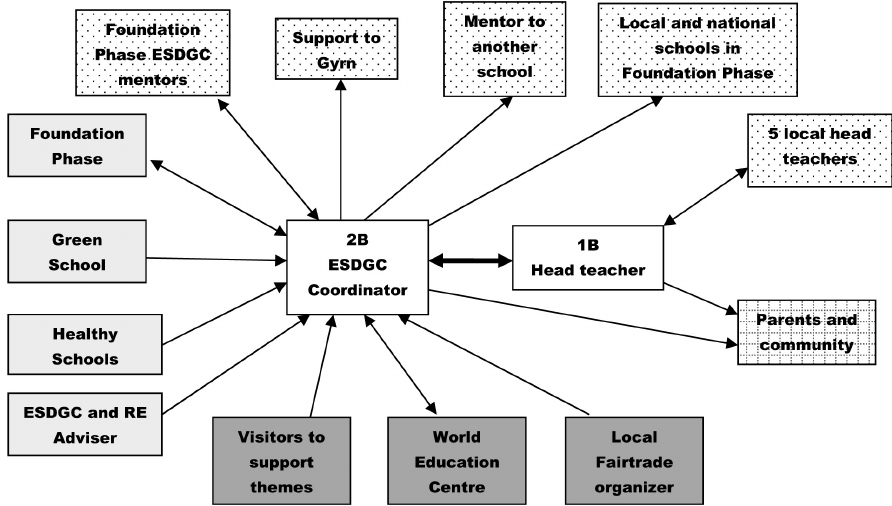
Figure 2: Bera teachers’ internal and external networks